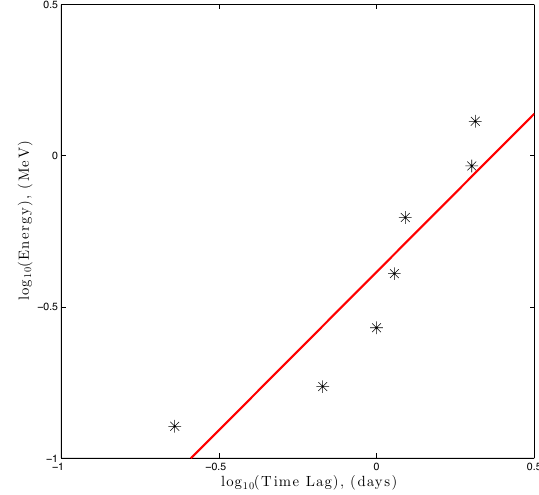
Fig. 5. Figure 1 from Boynton et al. (2013) displaying a log–log plot of the energy of the electron flux against the effective time delay of the solar wind velocity calculated from the NARMAX results. Also shown is the line of best fit in